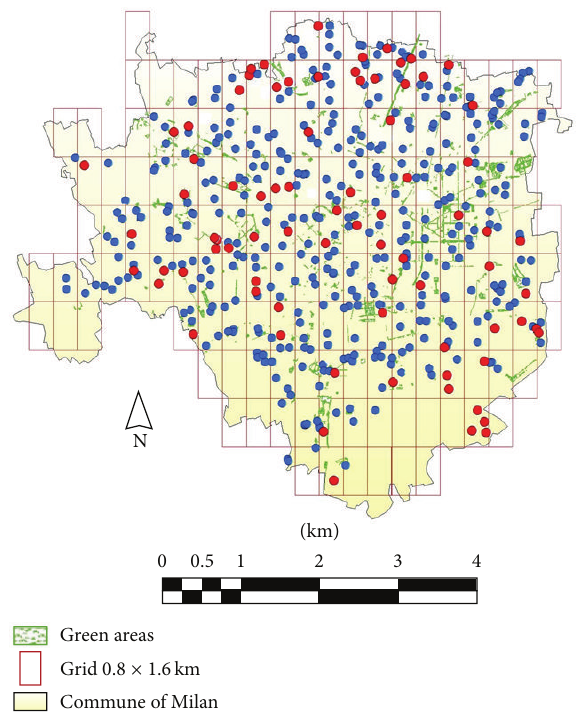
Figure1:Distributionofdogfaecalsamplesinthemetropolitanarea of Milan, north-western Italy. Location of negative (dot blue) and positive (dot red) dog faecal samples for parasitic elements.